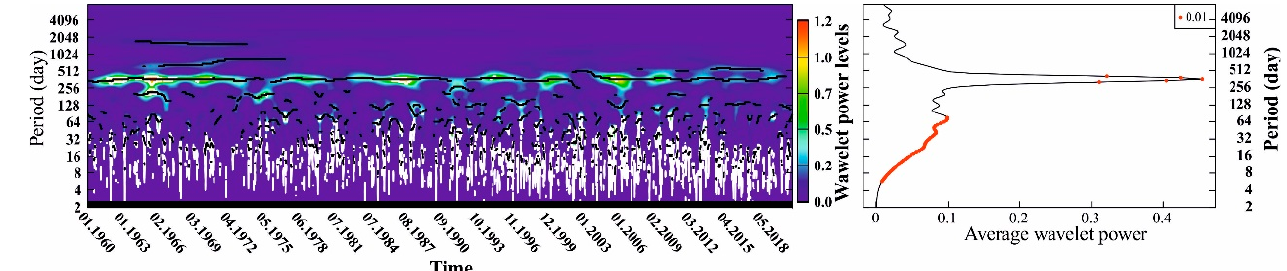
Figure 5. Power spectrum density (left panels) and time-averaged wavelet power (right panel) graphs indicating the presence of annual periodicity in water level time series at Kulcs for 1960–2020. The green contours in the left panels and the red dots in the right ones show the 99% confidence levels calculated against a thousand AR (1) surrogates. It should be noted that wavelet spectrum analysis coherence and wavelet transform coherence produce edge artifacts, since the wavelet is not completely localized in time, thus the introduction of a cone of influence (COI; dimmed area on the left panels) is suggested, in which edge effects cannot be ignored